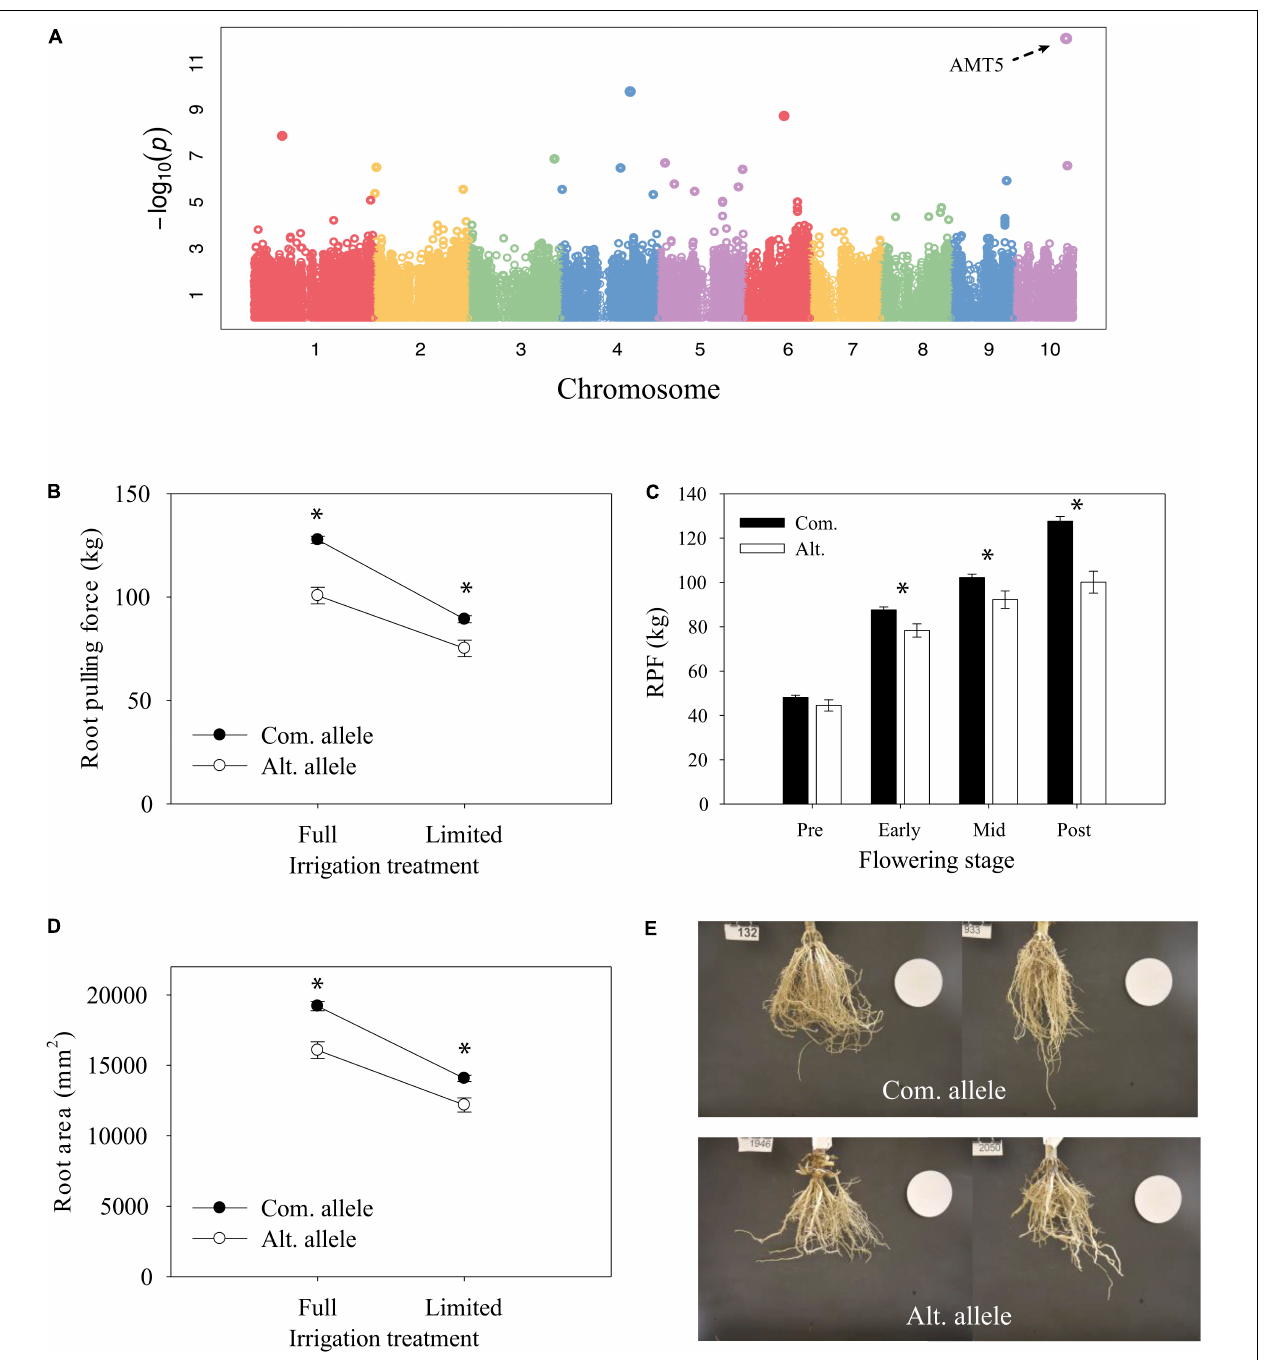
FIGURE 7 | Characterization of candidate gene AMT5 . (A) Genome-wide association mapping of RPF under well-irrigated conditions at 2018 post-flowering stage. (B) Reaction norm of RPF from 2018 post-flowering measurements for lines with contrasting alleles (ls mean ± SE). (C) Differences in RPF by allele across developmental time points for the full-irrigation treatment (mean ± SE). ∗ Indicates a significant difference, P < 0.05. (D) Reaction norm of root area (mean ± SE). (E) Representative root images for lines with the common allele (top) or alternate allele (bottom).